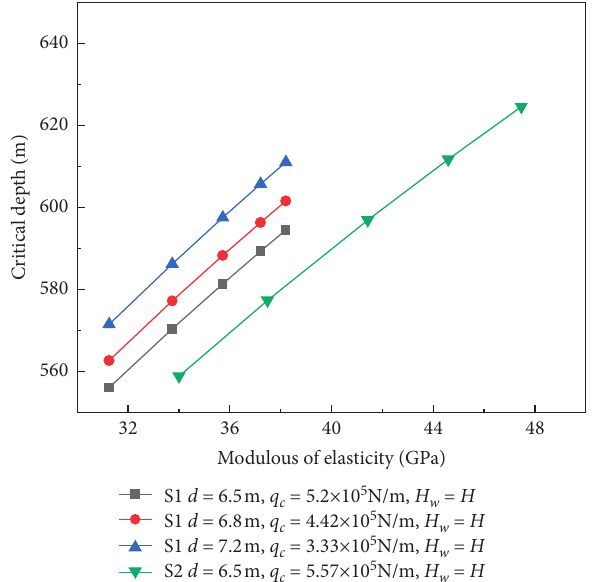
Figure 6: Relationship between elastic modulus and critical depth.